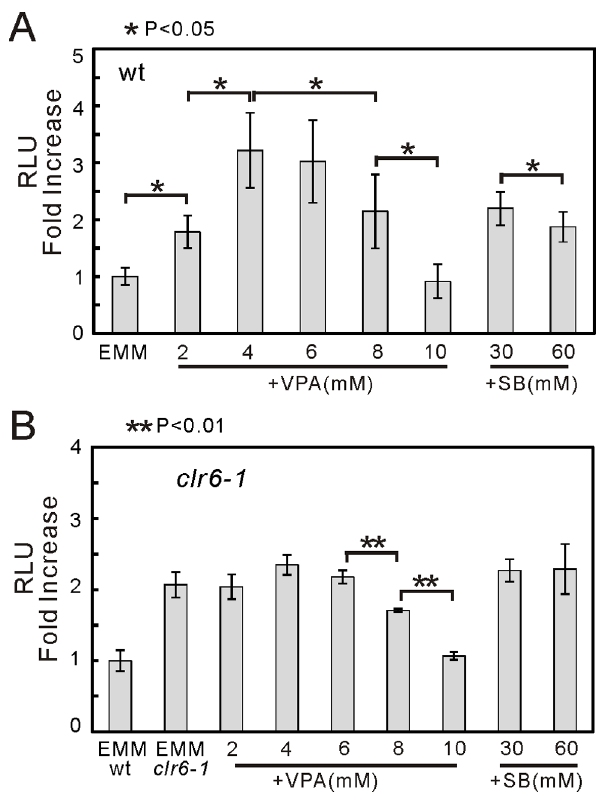
Figure 3. VPA and SB increased Atf1 transcriptional activity in a Clr6-dependent manner. (A) VPA or SB treatment markedly increased Atf1 transcription activity in wild-type cells. The wild-type cells harboring the multicopy plasmid (3XCRE::luc(R2.2) report plasmid) were grown to exponential phase, and assayed as described in Materials and Methods. The luminescence was followed for 5 hours. The data represent the accumulated value ratio of each sample (VPA or SB treatment) to the basal (EMM). Standard deviations are from three independent experiments, and each sample was analyzed in triplicate. Mean 6 S.D. (n=6). P , 0.05. (B) VPA or SB treatment failed to increase Atf1 transcription activity in clr6-1 mutant cells. The experiments were performed as described in Figure 3A, except clr6-1 mutant cells were monitored instead of the wild-type cells. Mean 6 S.D. (n=6). P , 0.01.